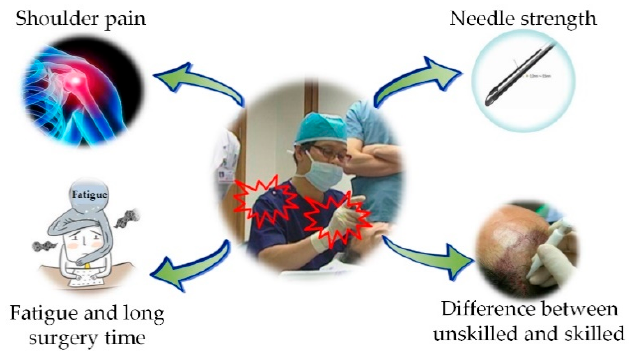
Figure 2. Problems of manual implanter.